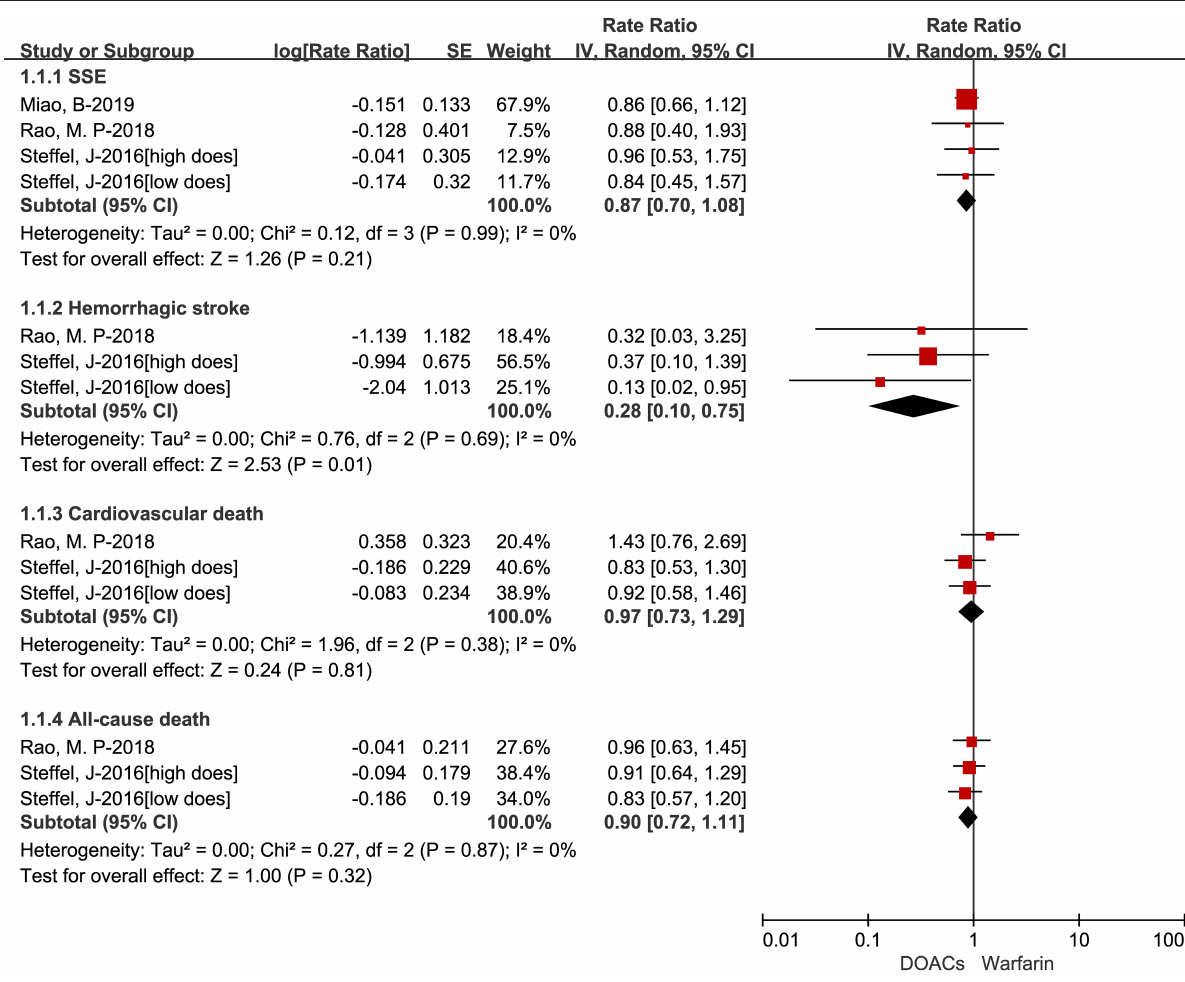
FIGURE 3 | Adjusted effectiveness data of direct oral anticoagulants compared with warfarin among atrial fibrillation patients at risk of falling. DOACs, direct oral anticoagulants; SSE, stroke or systemic